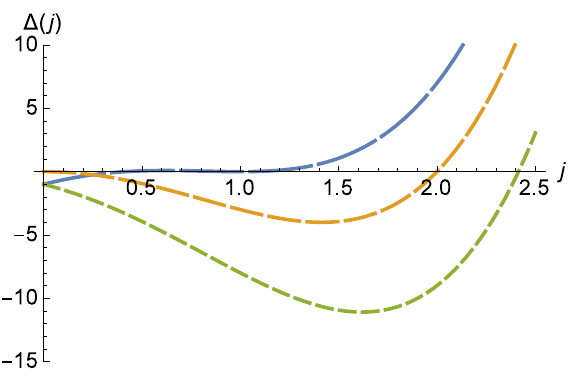
Figure 5. Determinant ∆ ( j ) = − 4 a 2 + 8 aj − 4 j 2 + j 4 as function of j for values a = 0.5 (blue upper line), 0 (yellow middle line), and a = − 0.5 (green lower line).